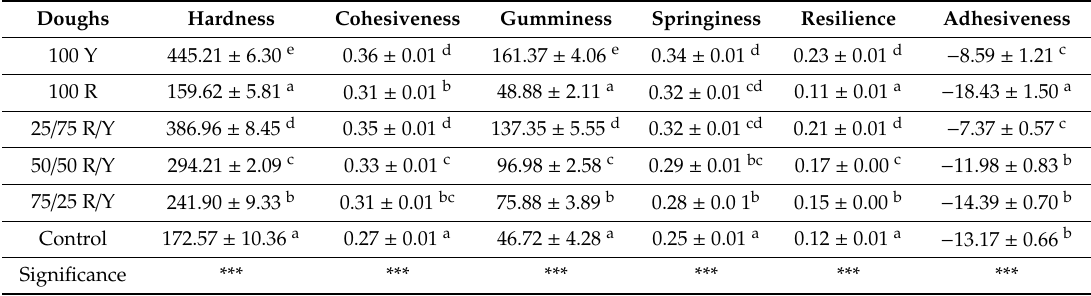
Table 6. Mean values ( ± standard error) of texture parameter evaluated on biscuit doughs produced with di ff erent date powders and results of variance analysis with Duncan’s test (R-red;